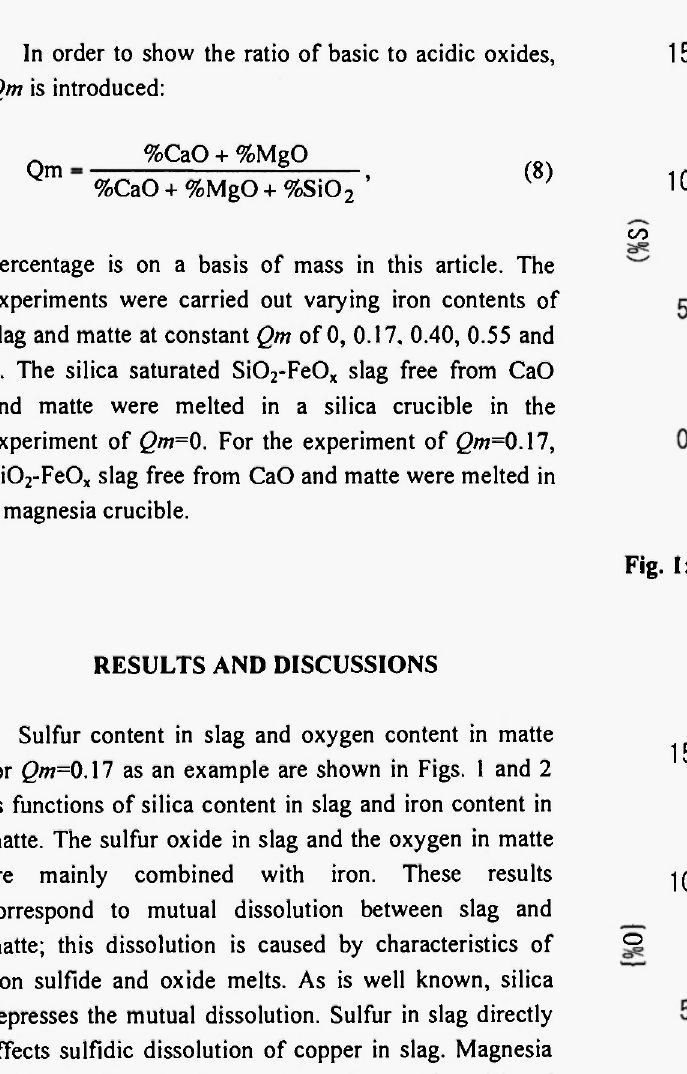
Fig. 2: Oxygen content in matte equilibrating with Si0 2 -Fe0 x slag melted in a magnesia crucible (g/w=0.17) at 0.01 MPa of S0 2 at